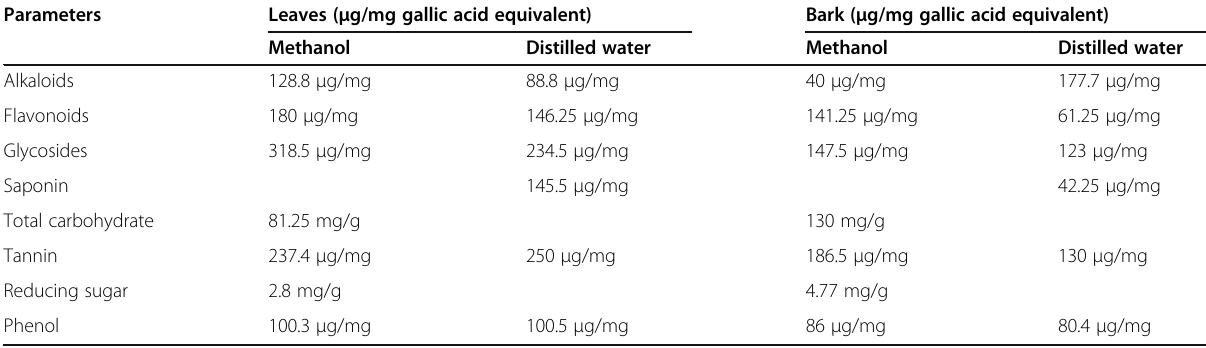
Table 5 Quantitative amount of phytoconstituents present in the leaves and bark of S . palghatense